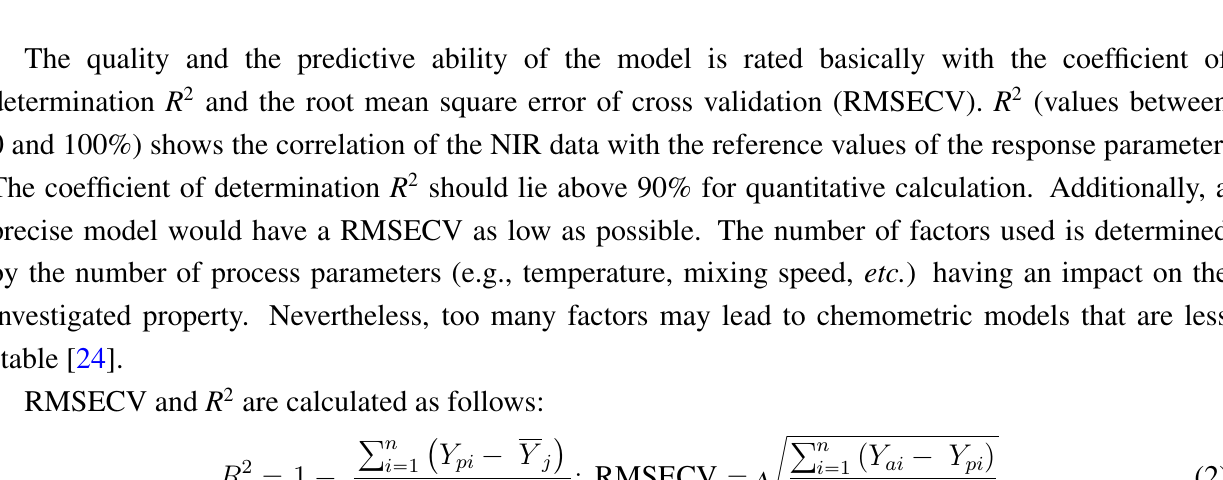
Figure 1. Principle of cross validation (according to Lohninger [23]).